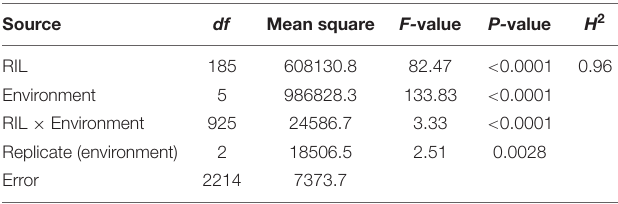
( Supplementary Figure 1 ). RL6058 has leaf rust resistance gene Lr34 . The marker adjacent to QLr.cau-6DL , cfd188, and